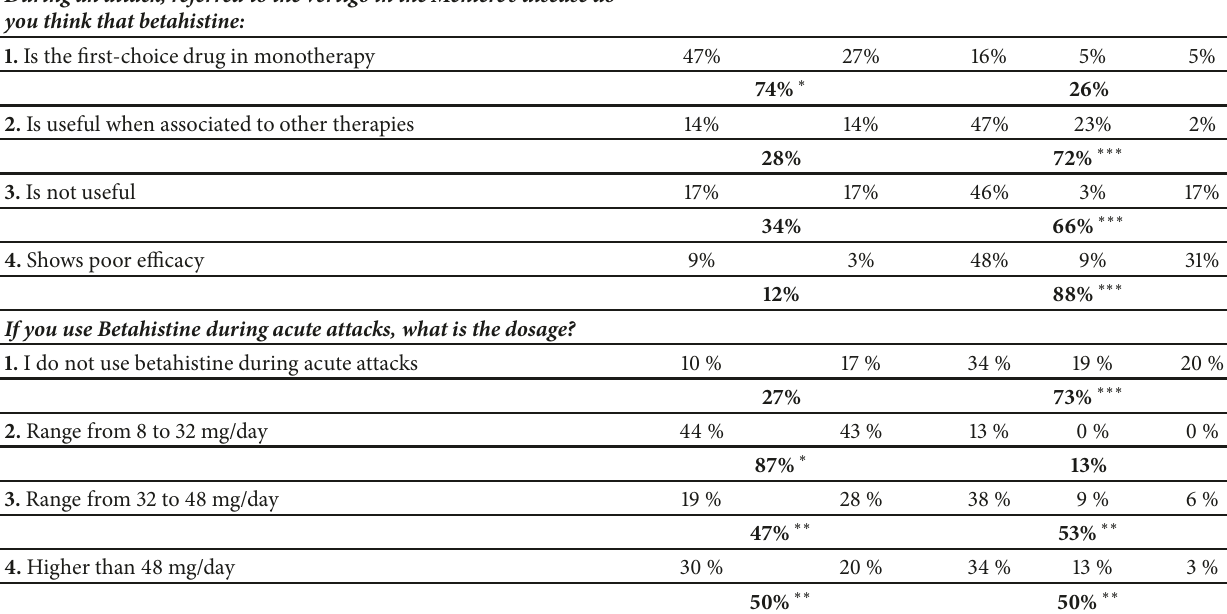
Table 2: Results of the Consensus Conference on the use and dosage of betahistine during the acute attacks of MD. 1 = absolutely disagree, 2 = disagree, 3 = agree, 4 = more than agree, and 5 = absolutely agree. Consensus was reached when the sum of items 1 and 2 or 3, 4, and 5 reached 66%. Same asterisk